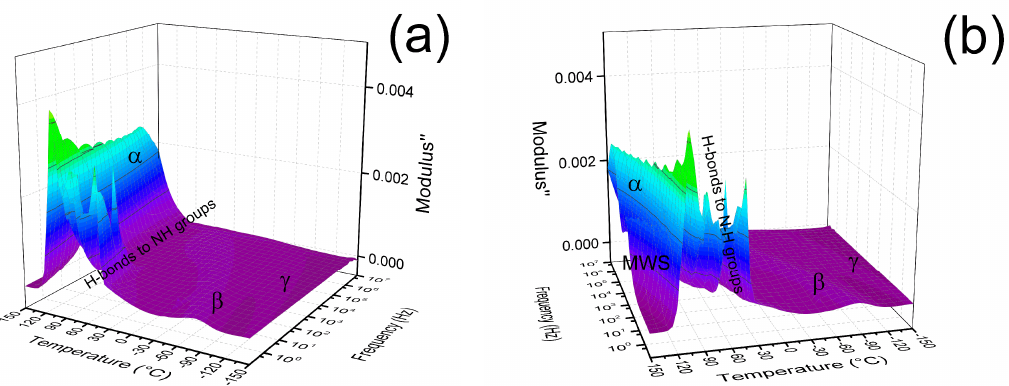
Figure 10. The dielectric maps for neat coPA matrix showing various types of relaxations, where ( a ) is neat coPA and ( b ) is neat coPa turned by 45° to right in order to highlight the MWS type of relaxation.